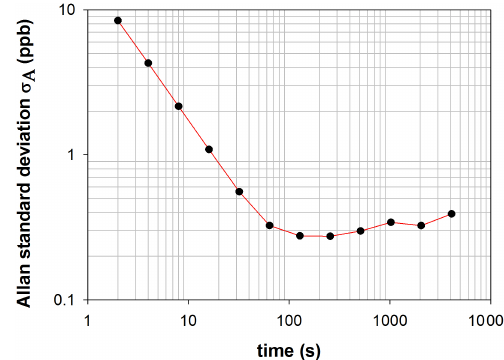
Figure 5. Allan variance vs. integration time calculated for the IB- BCEAS